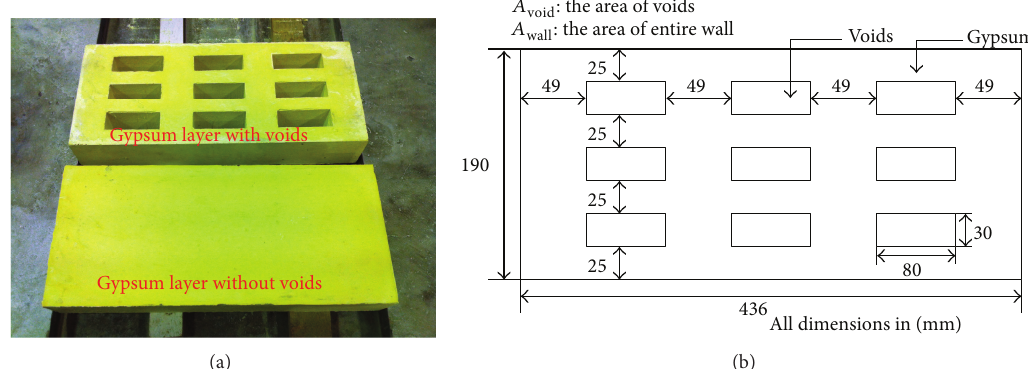
Figure 2: (a) Two types of tested gypsum layers: solid and gridded (with voids); (b) the key dimensions in the gypsum layer with